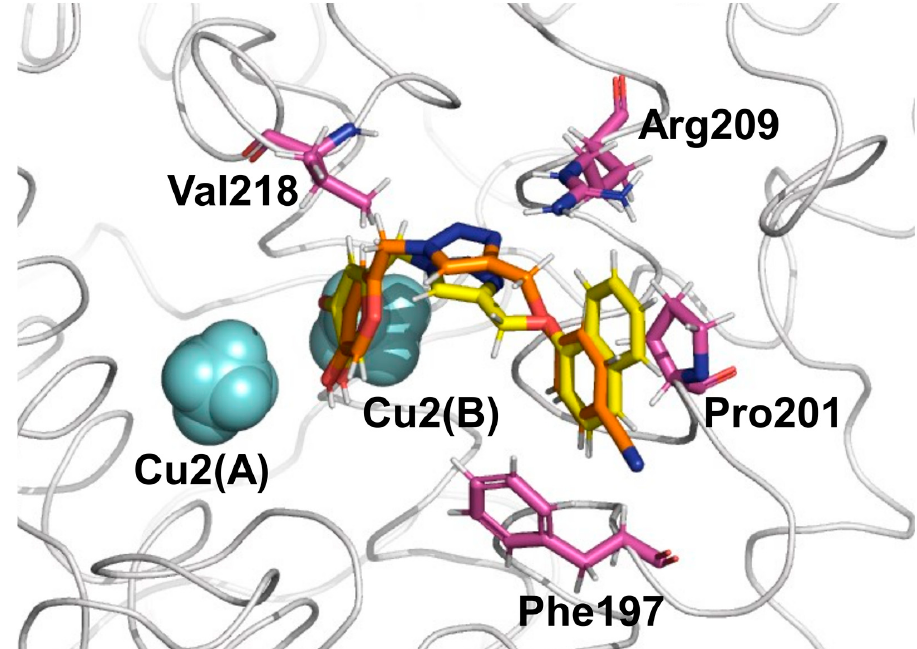
Figure 5. Four TYR residues make the most intense vdW contributions to binding for the inhibitors 6h (orange color for C atoms) and 6o (yellow color for C atoms) inhibitors. Cu 2+ ions are shown as light blue spheres.